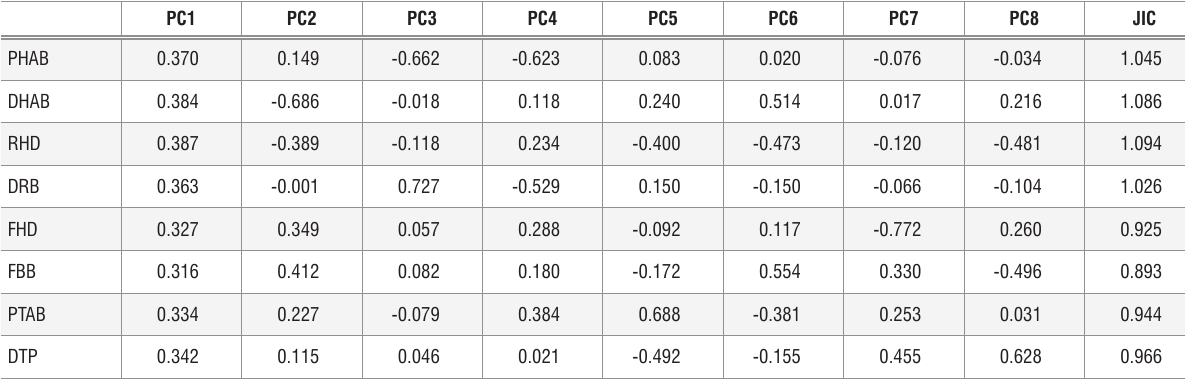
Component loadings for principal components (PC) analysis axes: large-bodied felids PC1